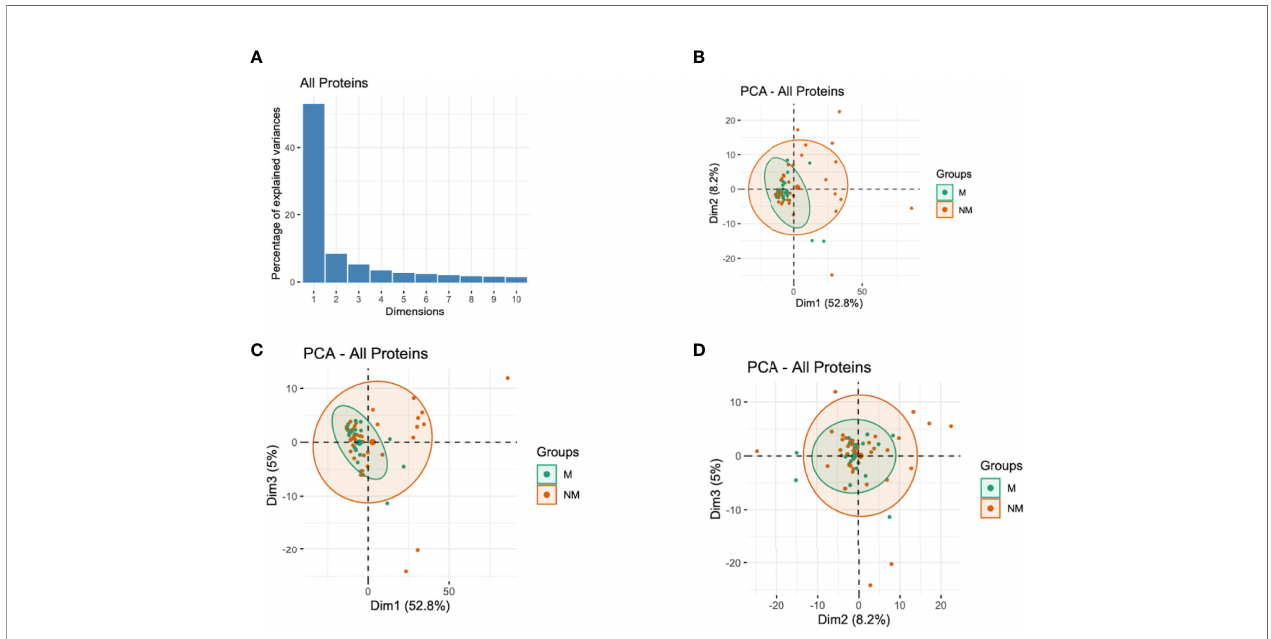
FIGURE 3 | Principal Components Analysis (PCA) of the antibody responses. (A) Distribution of principal components ( fi rst 10 dimensions) that explained the highest variance of the antibody responses derived from all the immunoreactive proteins. (B – D) The plots of the distribution of individuals by type of antibody responses to different proteins. The principal components (Dim)1 vs 2 (B) , Dim1 vs 3 (C) , and Dim2 vs 3 (D) that explained the highest percentage of the variance (percentage in parenthesis) of the antibody responses are presented. Green and red represent malaria (M) and no malaria (NM) cases, respectively. Light green and light red eclipses represent distribution of individuals with and without clinical malaria episodes,